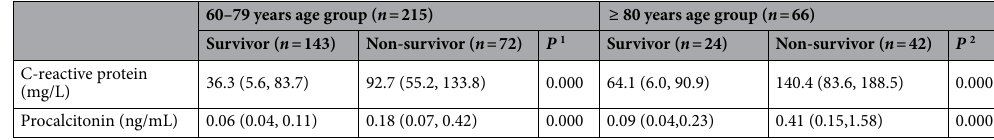
Table 3. Comparison of laboratory findings between survivors and non-survivors in the two age groups. Values are medians (interquartile ranges). P 1 indicates the P -values for the comparison of survivors and non-survivors in the 60–79 years age group; P 2 indicates the P -values for the comparison of survivors and non-survivors in the ≥ 80 years age group. ALT, alanine aminotransferase; AST, aspartate aminotransferase; APTT, activated partial thromboplastin time; hs-TNI, high-sensitivity troponin I; PRO-BNP, precursor-B-type natriuretic peptide.